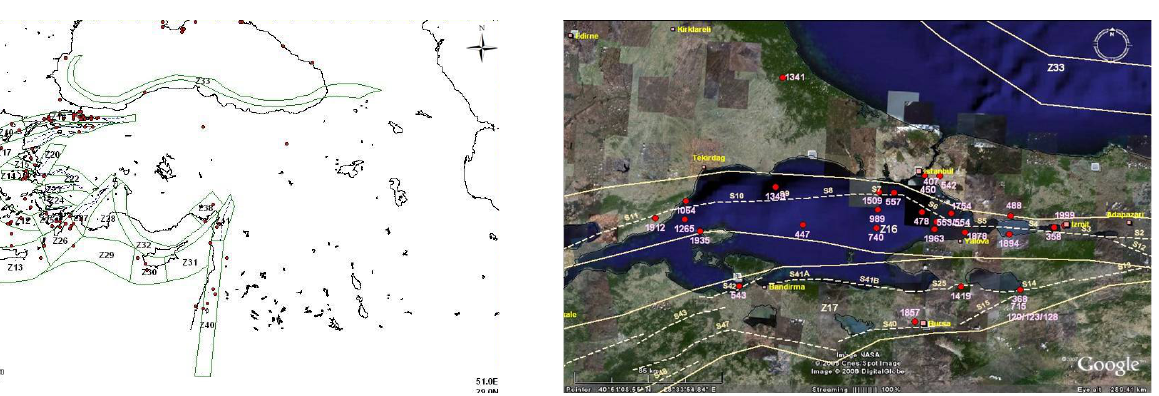
Figure 2. Tsunamigenic seismic zones (Zone 16 and 17) in the Marmara Sea region. Red dots represent the epicentres of historical earthquakes and the numbers just below or above them stand for the event’s years. The fault segmentation model developed by Erdik et al. (2004) for the North Western, South Western and Marmara Sea strands of the North Anatolian Fault System is shown by dashed lines with the numbers of each segment (e.g. S1, S2 etc.).